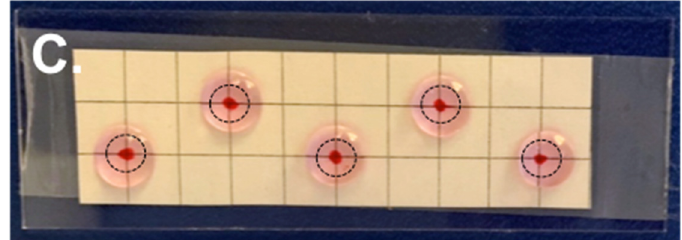
Figure 3. Deposition of poly-L-lysine onto Rain-X ® -coated slide. ( A ) A marked grid was affixed to the back of the microscope slide using tape. ( B ) Droplets 10 μ L in size containing 0.01% poly-L-lysine were spotted onto the microscope slide where indicated. ( C ) After removing excess poly-L-lysine, 50 μ L droplets containing the volumetrically concentrated samples were placed over the poly-L-lysine landing zone and allowed to dry. Location of landing zone in center of droplets indicated by dashed circle. Dyes added to droplets for visualization.